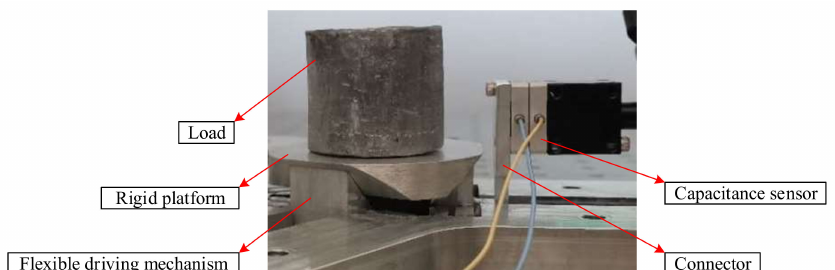
Figure 17. Bearing performance test.